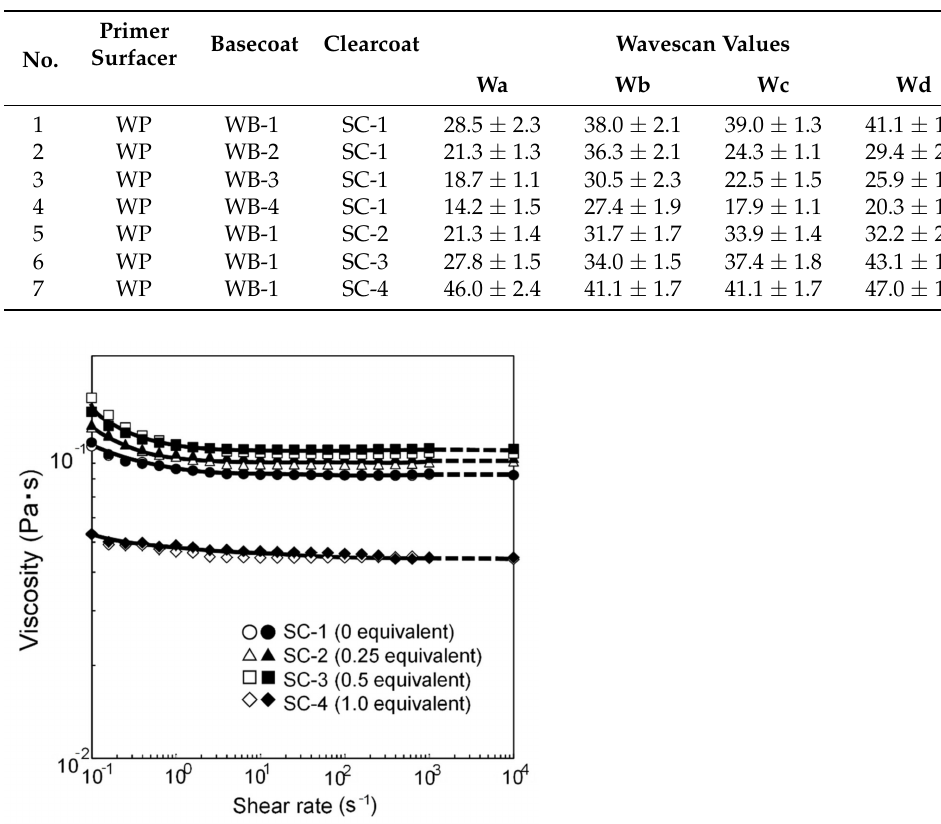
Table 7. Wavescan values obtained by changing basecoat and clearcoat.